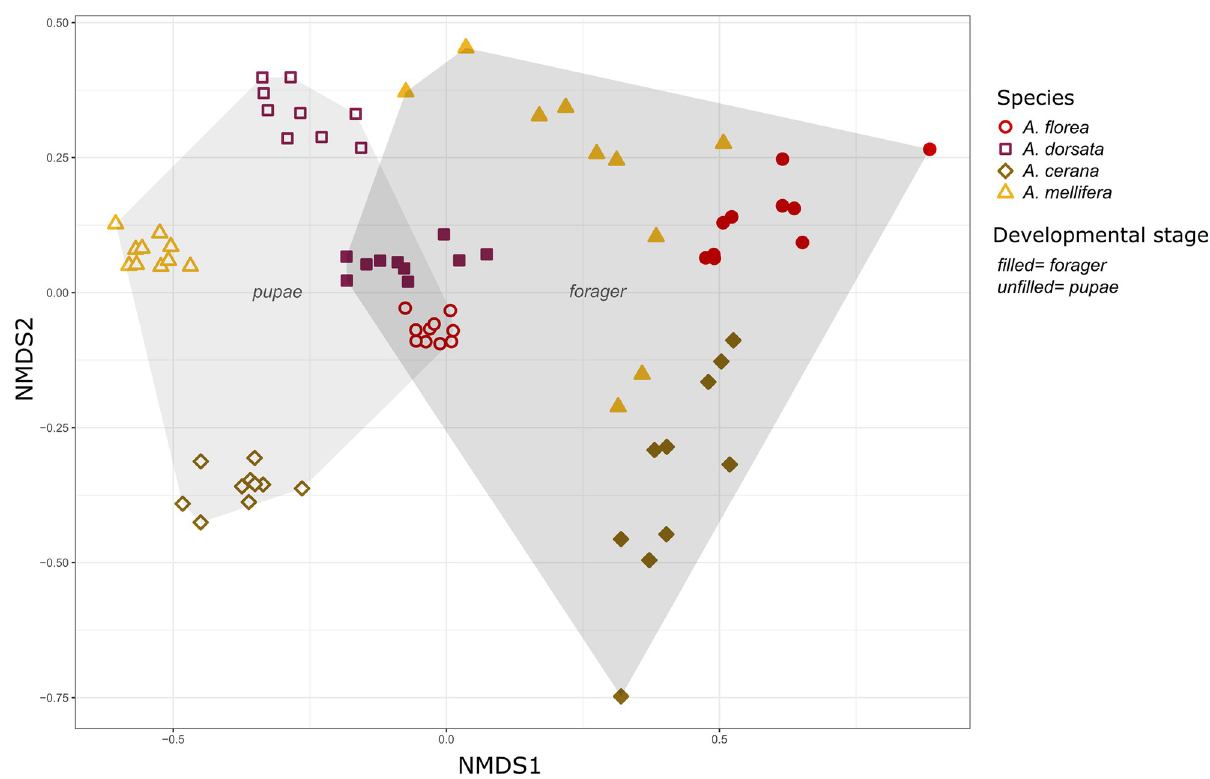
Fig 2. NMDS of CHC profiles. CHC profiles of pupae (unfilled) and foragers (filled) of the four honey bee species A . florea (circle), A . dorsata (square), A . mellifera (triangle) and A . cerana (diamond) displayed in a two-dimensional graph by non-metric multidimensional scaling (NMDS) of Bray-Curtis distances.